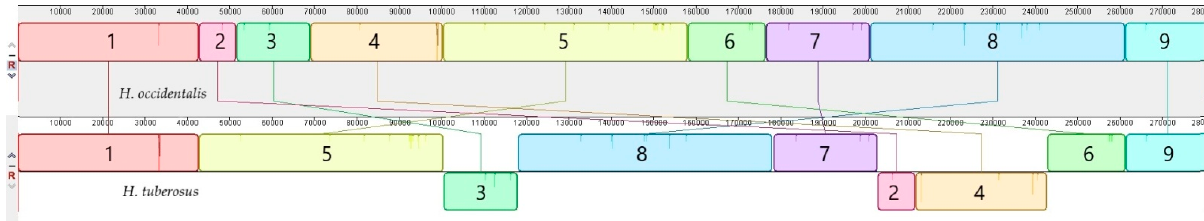
Figure 2. The progressive MAUVE alignment of H. occidentalis and H. tuberosus complete mitogenomes. According to sequence similarity, 9 syntenic blocks with a different order were identified.